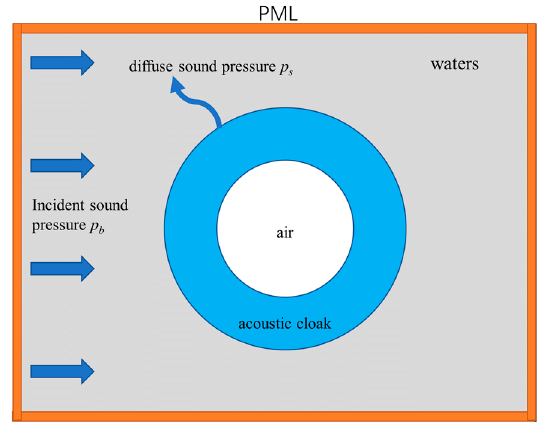
Figure 11. Pentamode material acoustic stealth cloak structure: ( a ) actual structure; ( b ) homogenization structure.